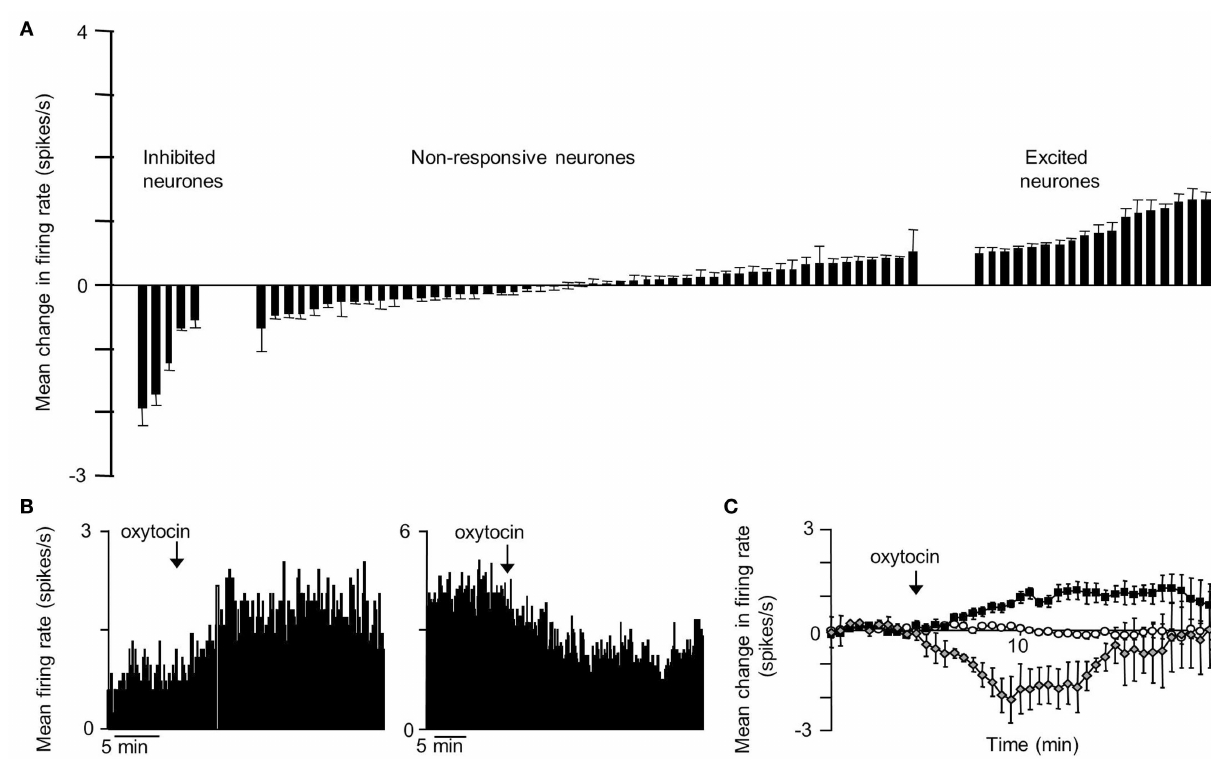
FIGURE 1 | Responses to icv oxytocin inVMN neurons in vivo . Single VMN neurons were recorded extracellularly from theVMN of urethane-anesthetized rats (Sabatier and Leng, 2008). (A) Each bar represent the mean change in firing rate ( ± SD) averaged over the first 10min after icv injection of oxytocin (1–10ng) in eachVMN cell tested.The cells are ranked by response magnitude and are classed as inhibited, non-responsive, and excited